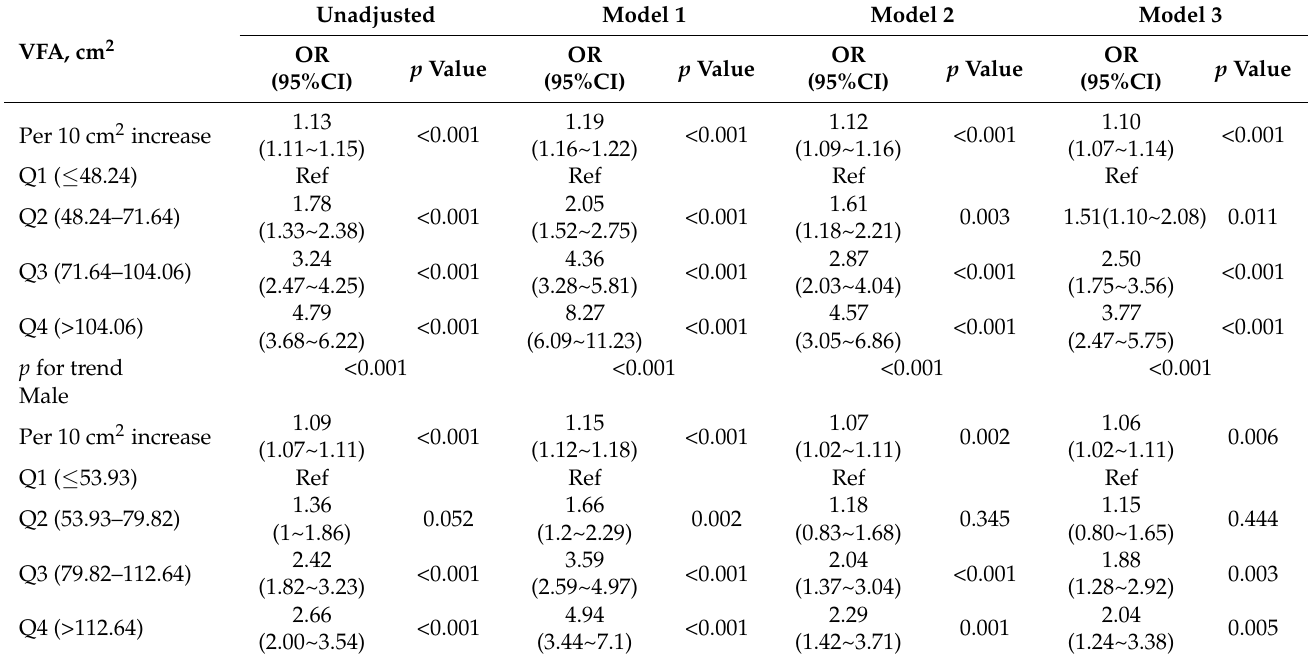
Table 3. Multivariable-adjusted ORs and 95%CI of the VFA quantiles associated with